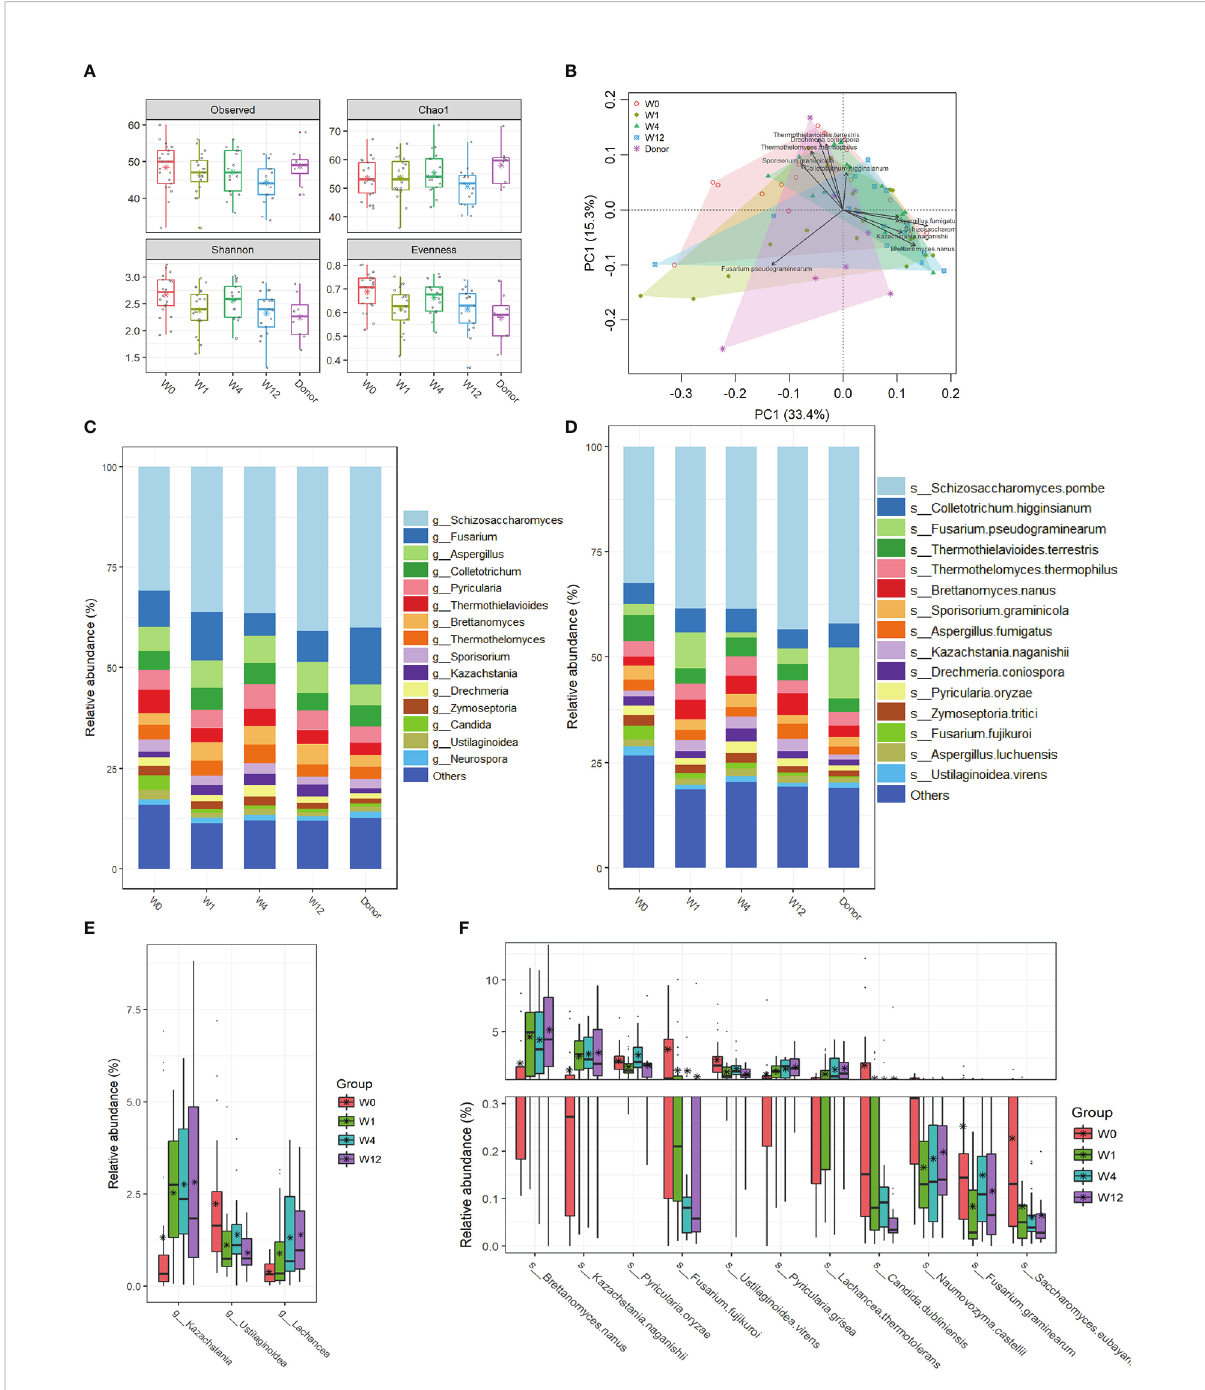
FIGURE 4 Changes of gut fungal communities of UC patients after FMT. (A) a -diversity indices in UC patients were analyzed during the follow-up visits, including observed OTUs, Chao 1, and Shannon and Pielou ’ s evenness indices. (B) Clusters of gut fungal community were analyzed using PCA of the Euclidean distance of OTU abundance. The top ten genera were fi tted to PCA with a statistical signi fi cance of p < 0.05. Relative abundances of the top 15 genus (C) and species (D) in samples from donors and patients before and after FMT. (E) The signi fi cant change in relative abundances of genera in samples from patients between week 0 and other time points after FMT. (F) The signi fi cant change in relative abundances of species in samples from patients between week 0 and other time points after